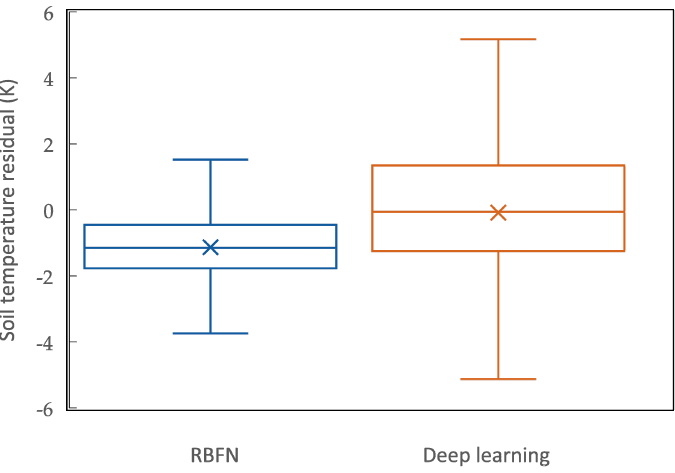
Figure 7. Box plot of soil temperature residuals computed by RBFN and Deep